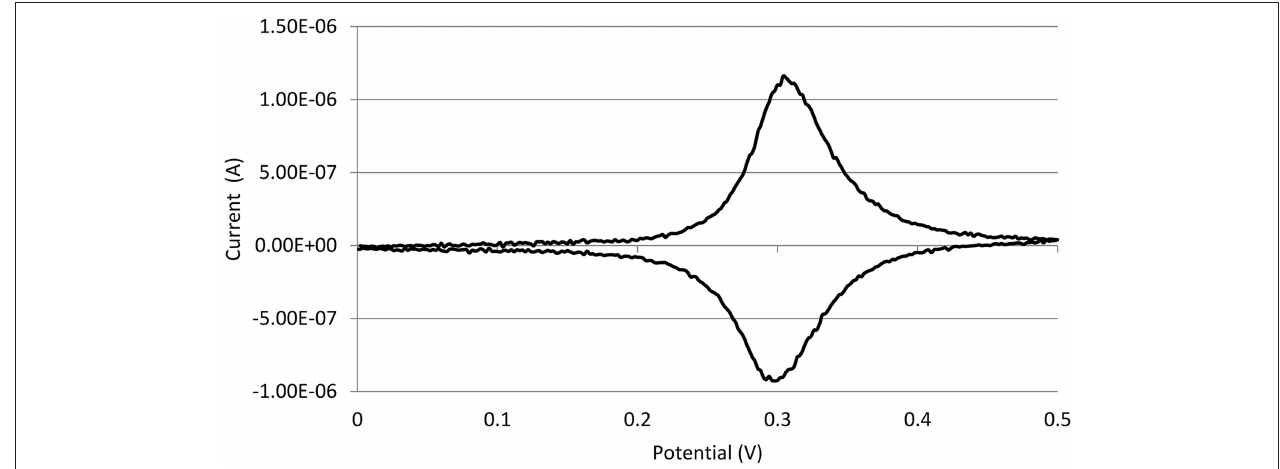
FIGURE 3 | Characterization of Os-HRP modified carbon electrode. Characterization of the Os-HRP modified carbon electrode: cyclic voltammetry was performed for the basic characterization of the modified electrode. Cyclic voltammetry was conducted at a scan rate of 20mV/s from 0.0 to + 0.5V at room